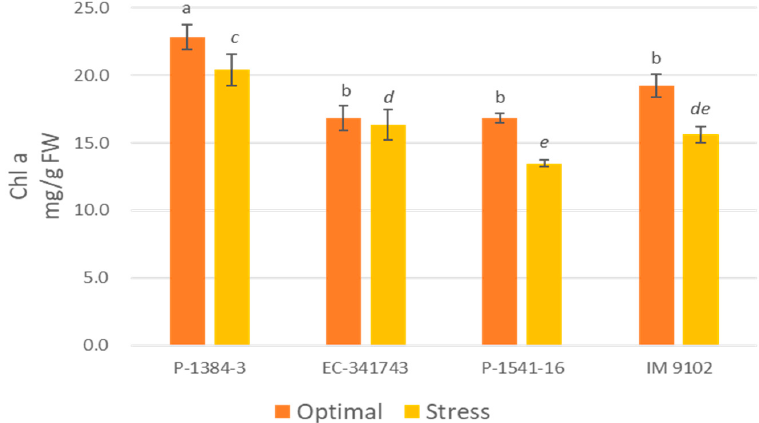
Figure 1. Chlorophyll-a content of four field pea genotypes under optimal and heat stress. Columns with different letters indicate significant difference at p ≤ 0.05 (Fisher LSD test).